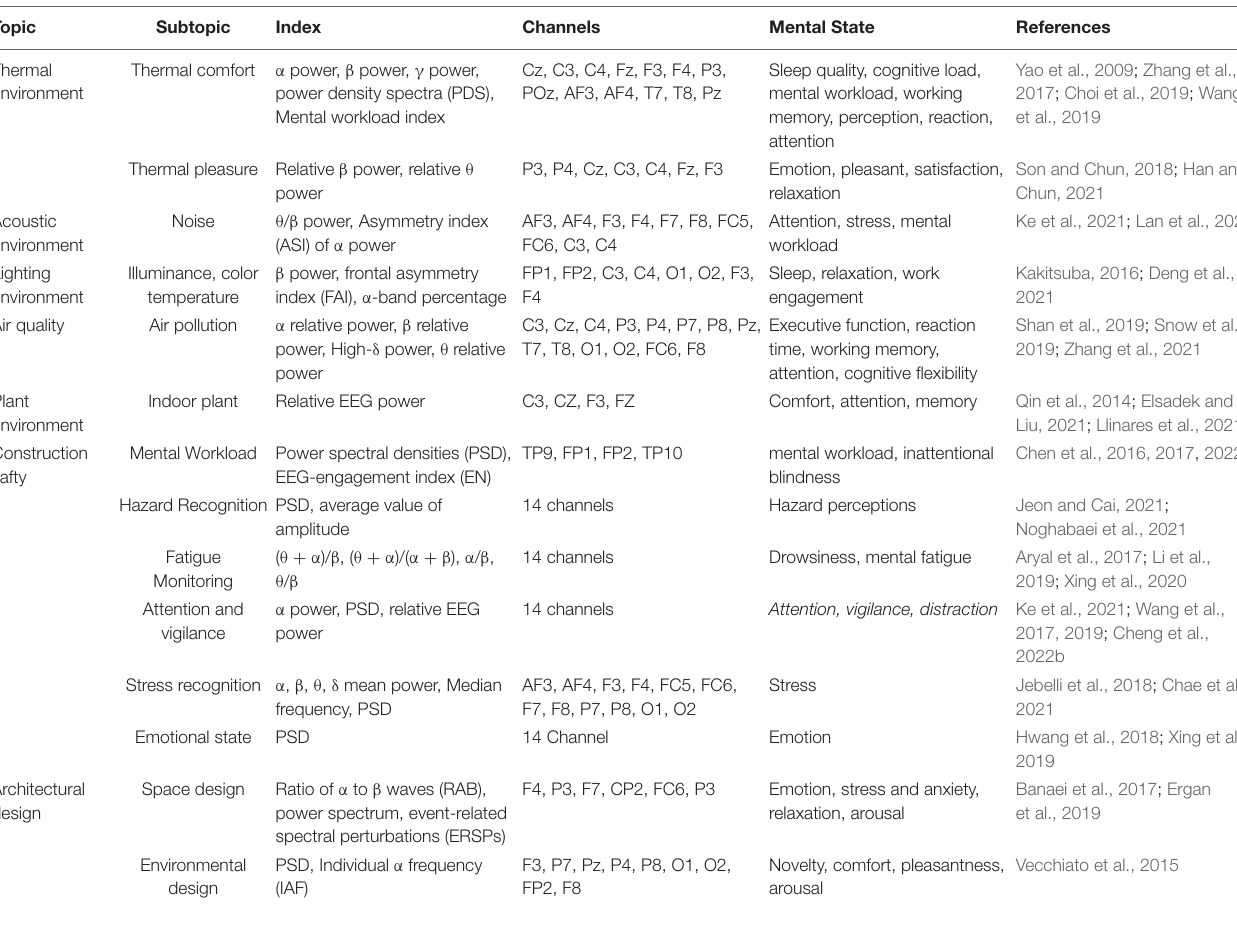
TABLE 5 | Research summary of EEG applications in building